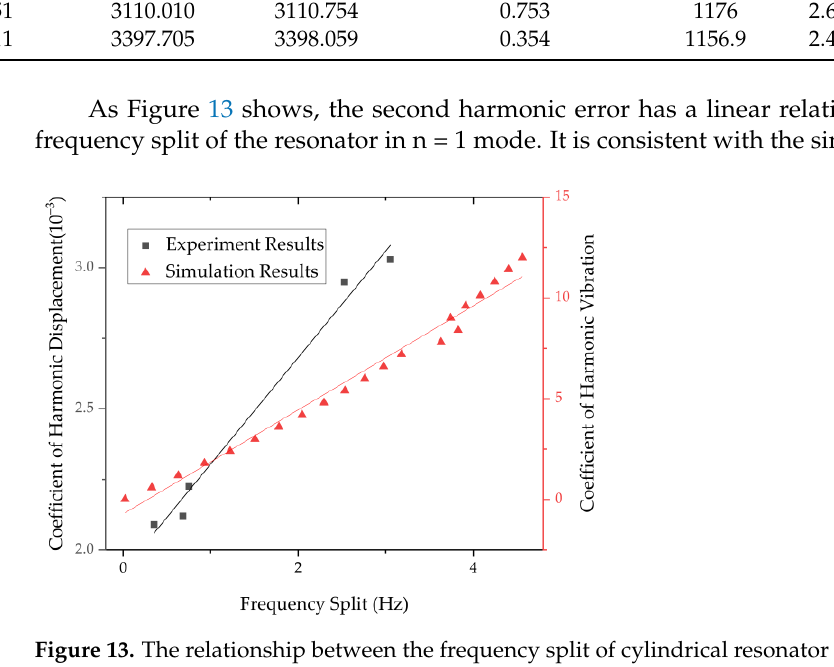
Figure 13. The relationship between the frequency split of cylindrical resonator in n = 1 mode and the coefficient of harmonic